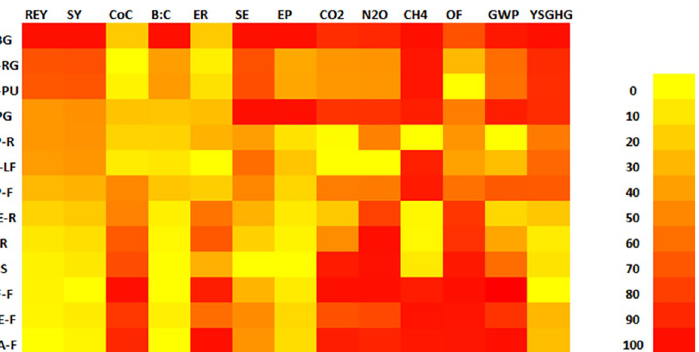
Fig 13. Comparison of different rice-based cropping systems based on productivity, profitability, energetics and GHGs emission indicators. Indicators are transformed into 0–100 scale for rendering comparability. [here, R-BG: rice-bitter gourd, R-P-RG: rice-potato-ridge gourd, R-P-PU: rice-potato-pumpkin, R-PG: rice-pointed gourd, R-P-R: rice-potato-rice, R-P-LF: rice-potato-ladies finger, R-P-F: rice-potato-fallow, R-LE-R: rice-lentil-rice, R-R: rice-rice, R-S: rice-sunflower, R-F-F: rice-fallow-fallow, R-LE-F: rice-lentil-fallow, R-LA-F: rice-lathyrus-fallow]; REY: rice- equivalent yield, SY: system yield, CoC: cost of cultivation, B:C: benefit:cost ratio, ER: energy ratio, SE: specific energy, EP: energy productivity, CO 2 , N 2 O, CH 4 and OF: emission of CO 2 , N 2 O and CH 4 and from off-farm transport, GWP: global warming potential, YSGHG: yield-scaled GHG